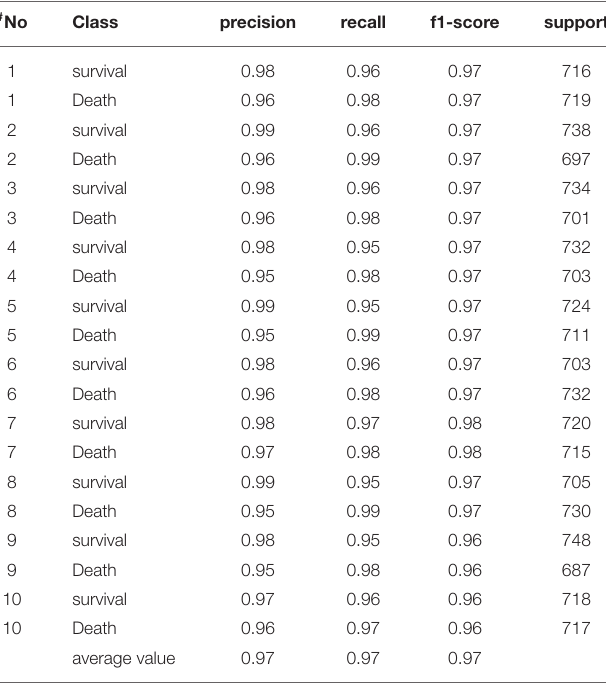
TABLE 2 | The results of model training based on laboratory measurements of COVID-19 patients in Leishenshan Hospital, China. No Data